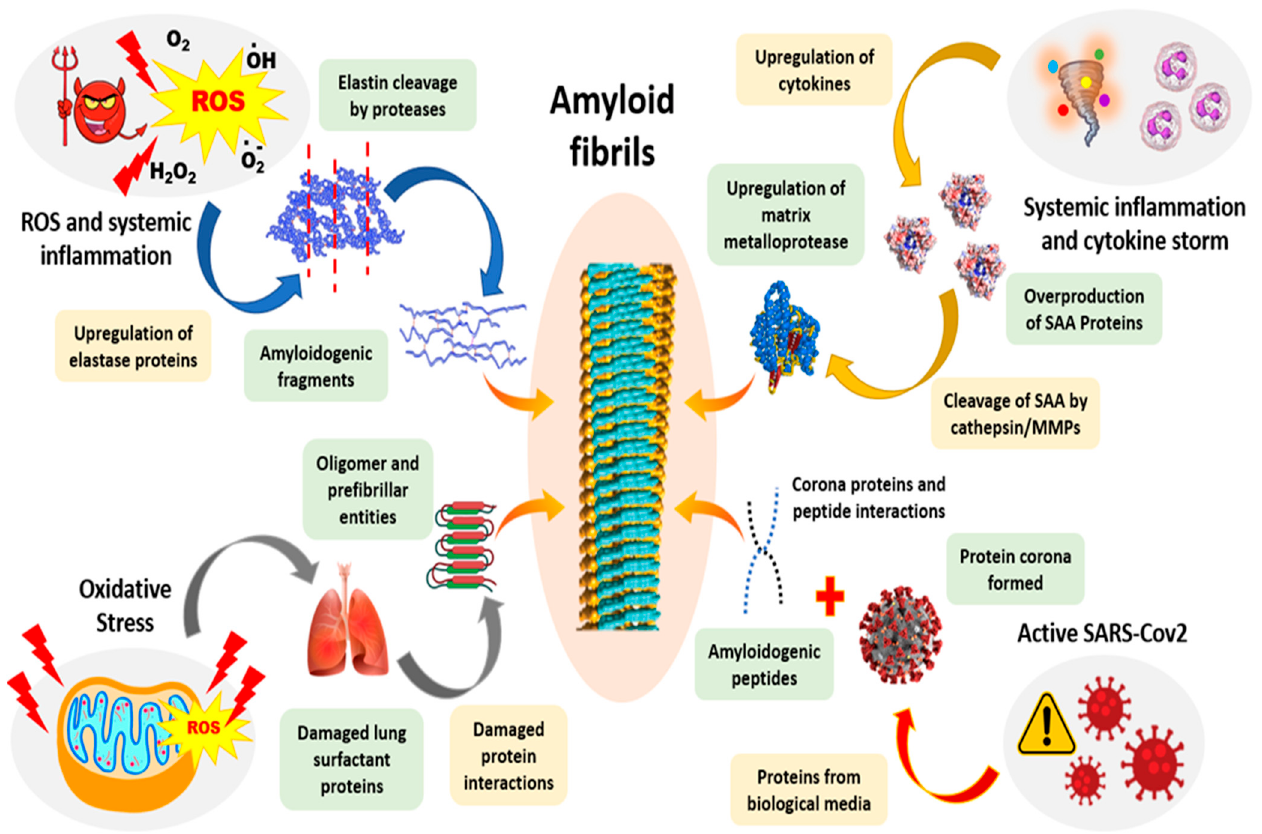
Figure 10. SARS-CoV-2 induced acute respiratory syndromes lead to upregulation of ROS and inflammation that can potentially lead to amyloidosis.